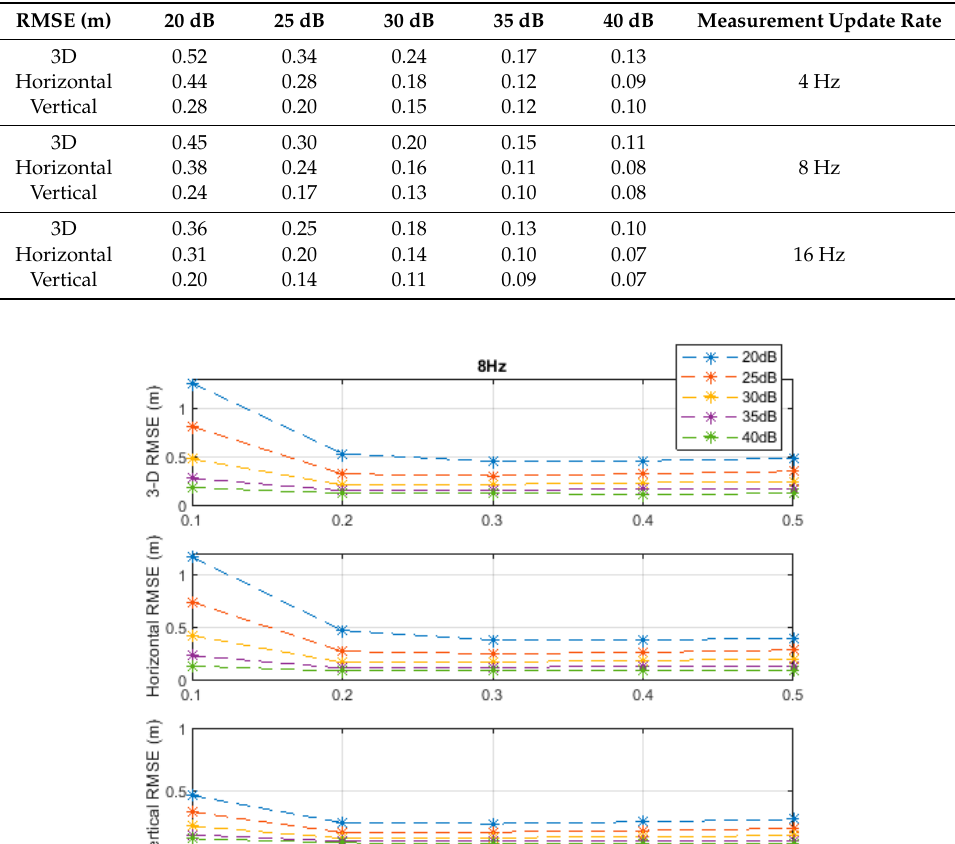
Table 5. Best accuracies obtained at all investigated SNR levels and measurement update rates in the helical path experiments.